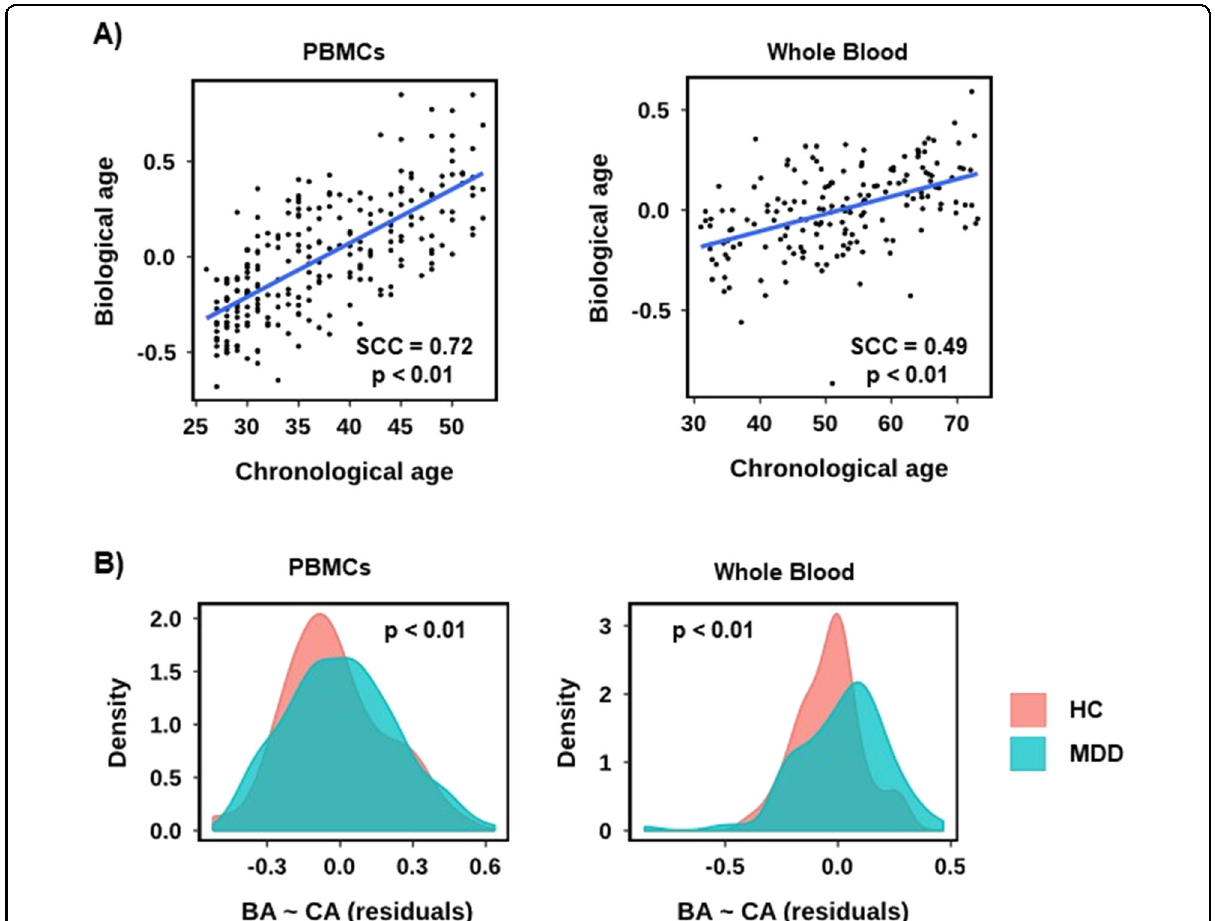
Fig. 4 Relative to patient age biological age is greater in MDD patients than in HC. A Scatterplots for PBMC RNA-seq data (left) and whole blood expression microarray data (right), showing the correlation between chronological age ( x -axis) and biological age ( y -axis) as de fi ned by the mean expression z -score across all age-related genes, per sample. A linear regression line, alongside the Spearman Correlation Coef fi cient (SCC) and associated p -value is shown. B Density plots of the residuals from the linear regressions in A . A positive residual indicates a sample above the regression line and negative